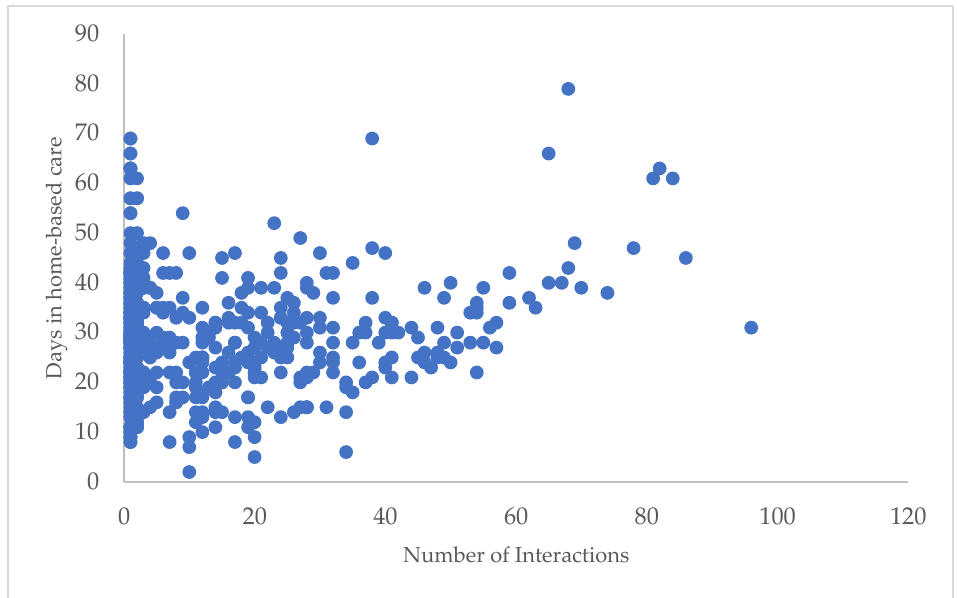
Figure 10. Daily interaction vs. days in home-based care.